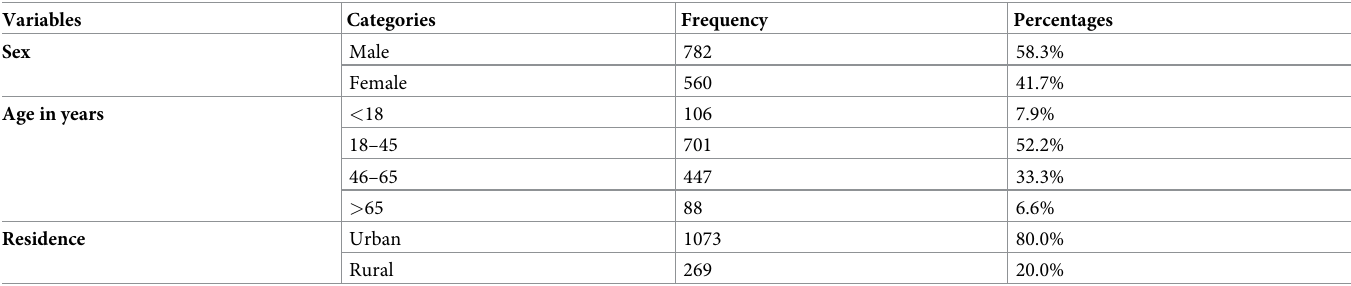
Table 1. Sociodemographic characteristics of study participants at UoG-CSH and Bahir-Dar Felegehiwot comprehensive specialized hospital: Northwest Ethiopia.